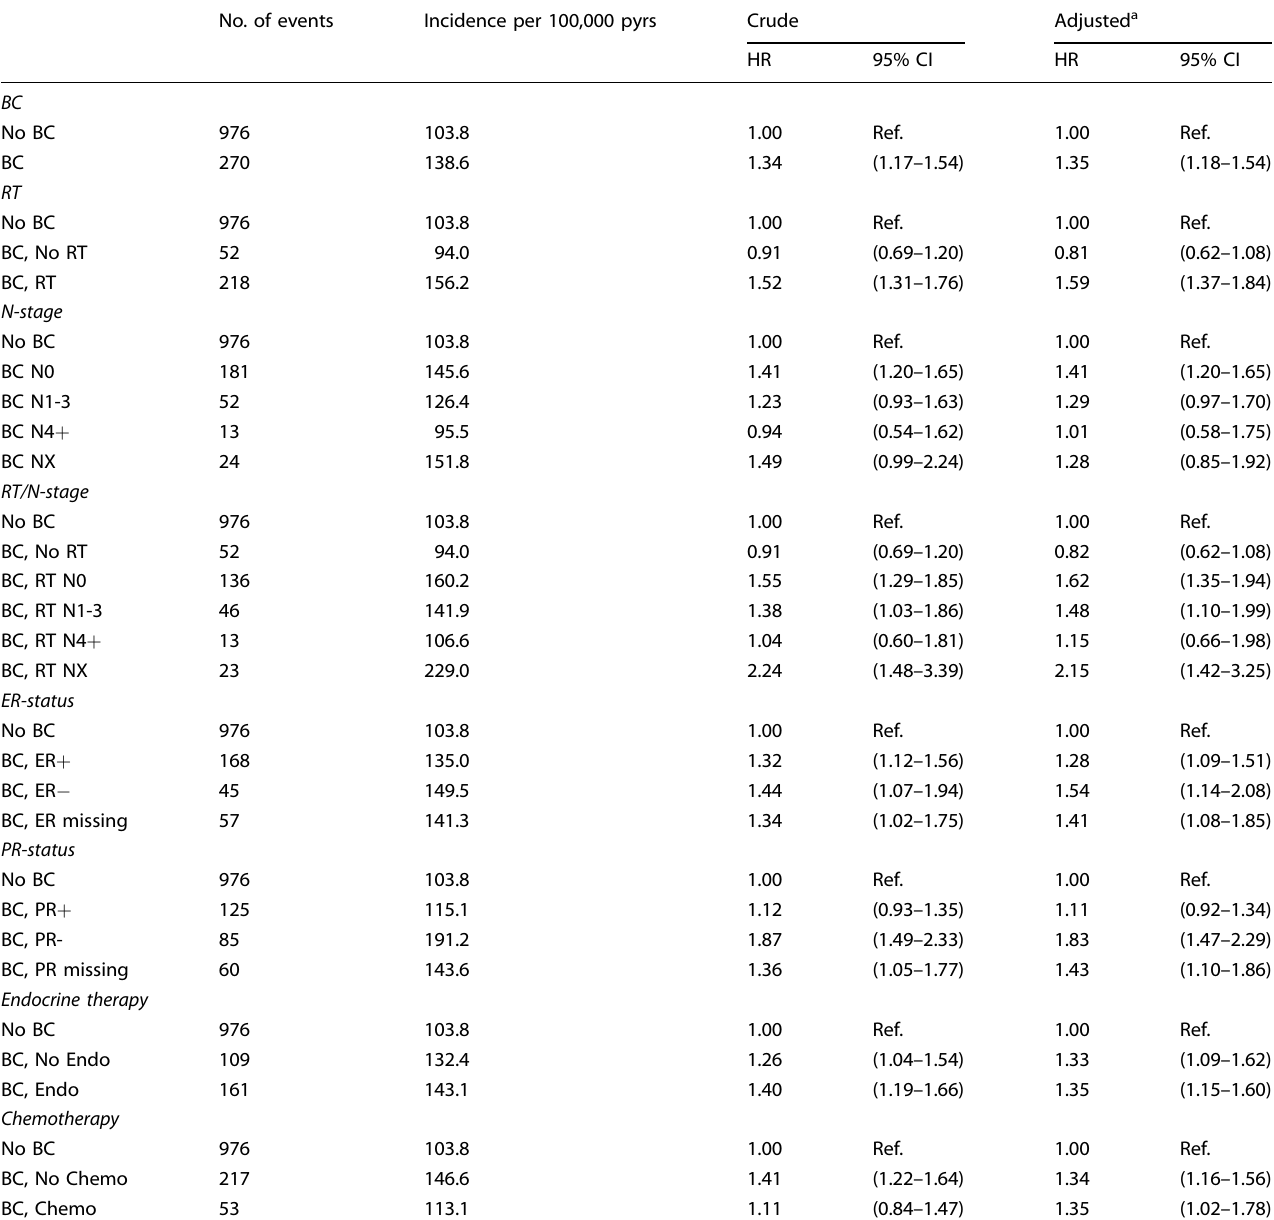
Table 1. Risk of lung cancer in women with breast cancer compared to women without breast cancer